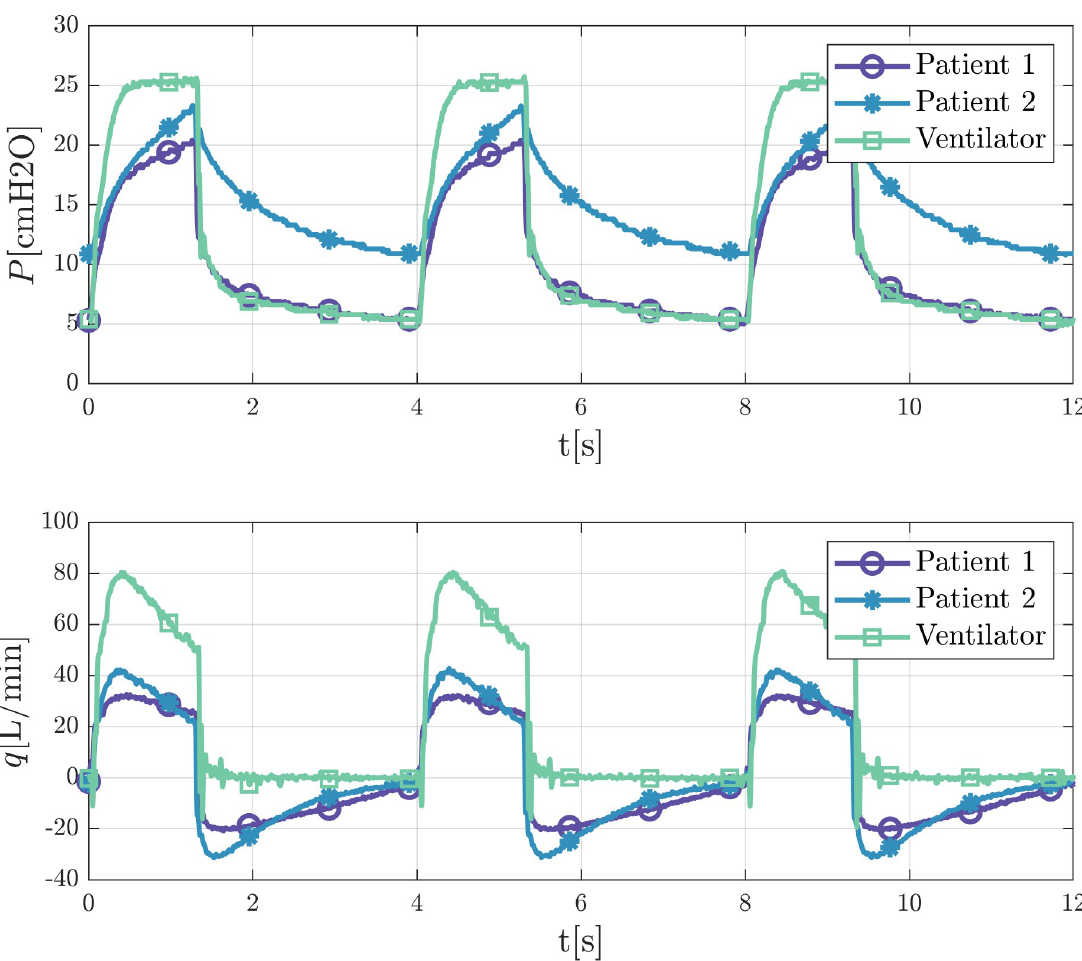
Fig 2. Typical output for pressure and flowrate signals of the ventilator and of artificial lungs probes with different working parameters.